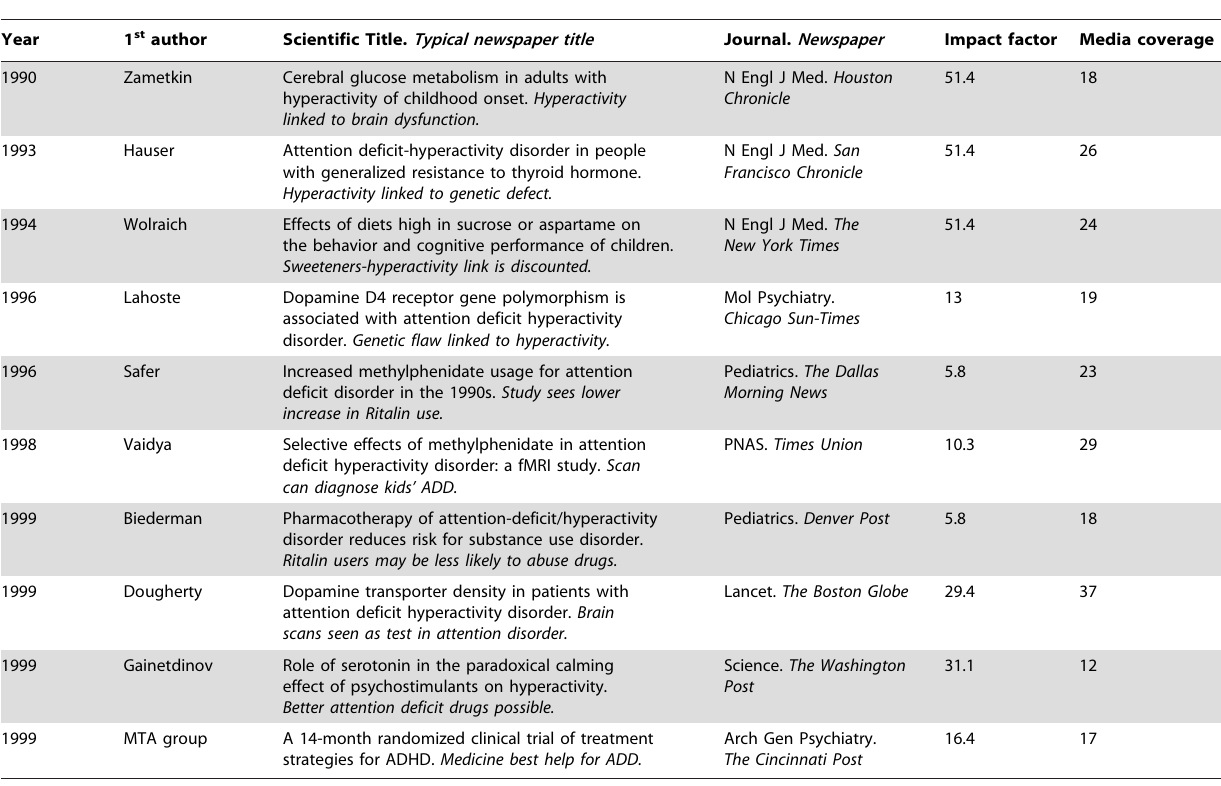
Table 1. ‘‘Top 10’’ scientific studies published between 1990 and 1999 and most frequently echoed by